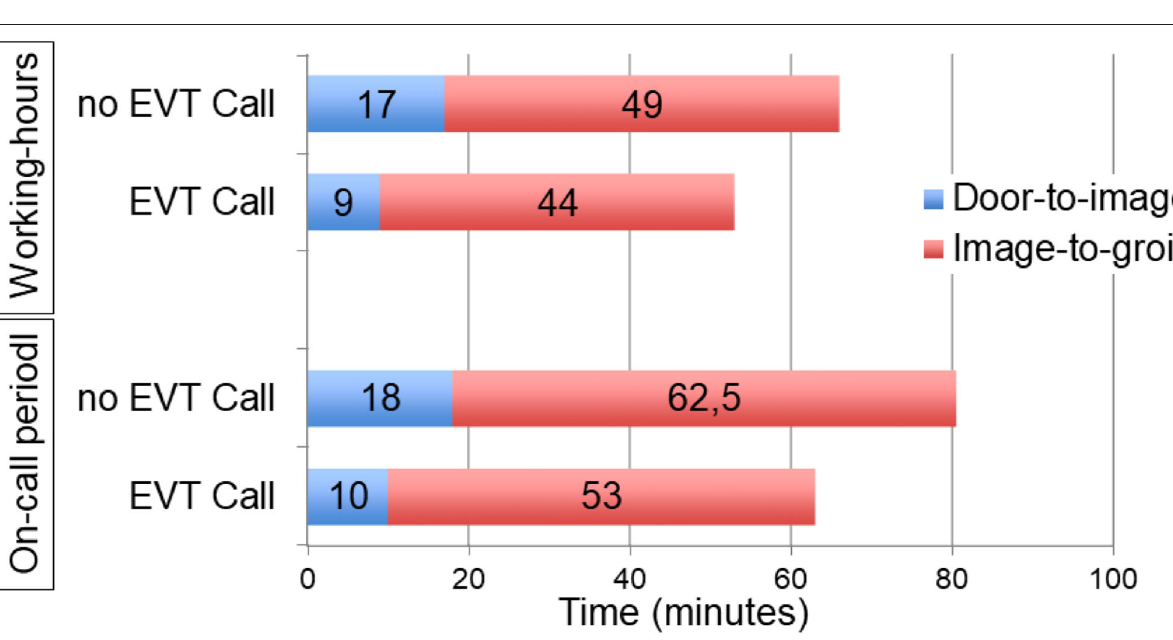
door-to-groin times were comparable to our data (door-to-image time: 15 min [10–23]; image-to-angio time: 22 min